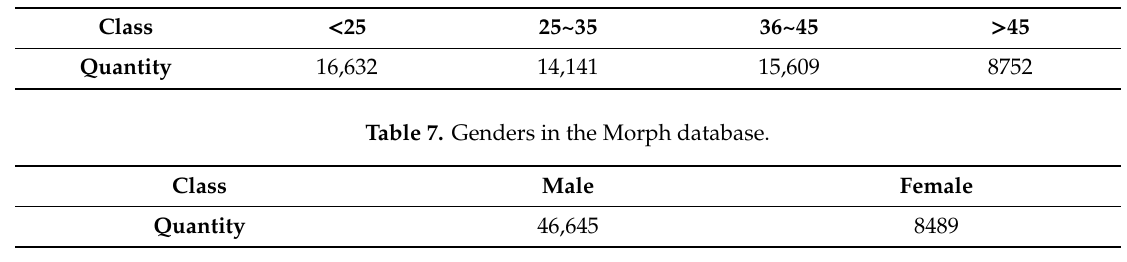
Table 8. Age classification results of the Morph database by the three CNNs.